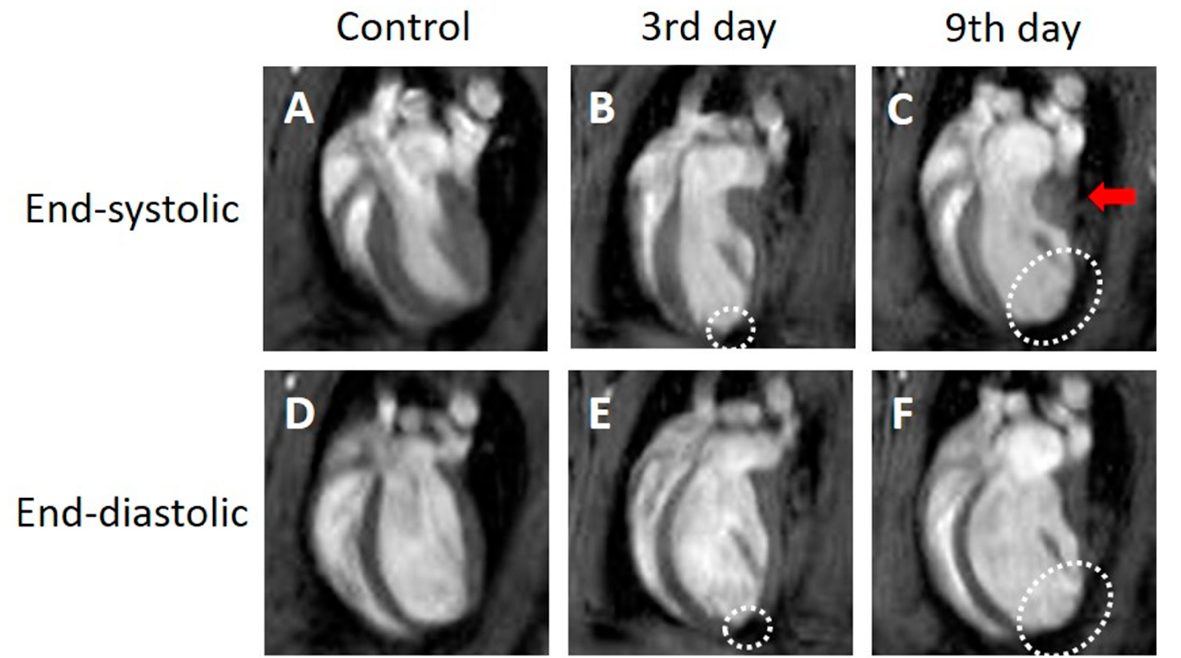
Figure 1. Representative four-chamber view cine magnetic resonance images. Control ( A , D ), 3 days after the onset of myocardial infarction ( B , E ), 9 days after the onset of myocardial infarction ( C , F ). End-systolic phase of the rat heart ( A , B , C ), end-diastolic phase of the rat heart ( D , E , F ). White dotted circles: infarcted area. Red arrow: thickened area.